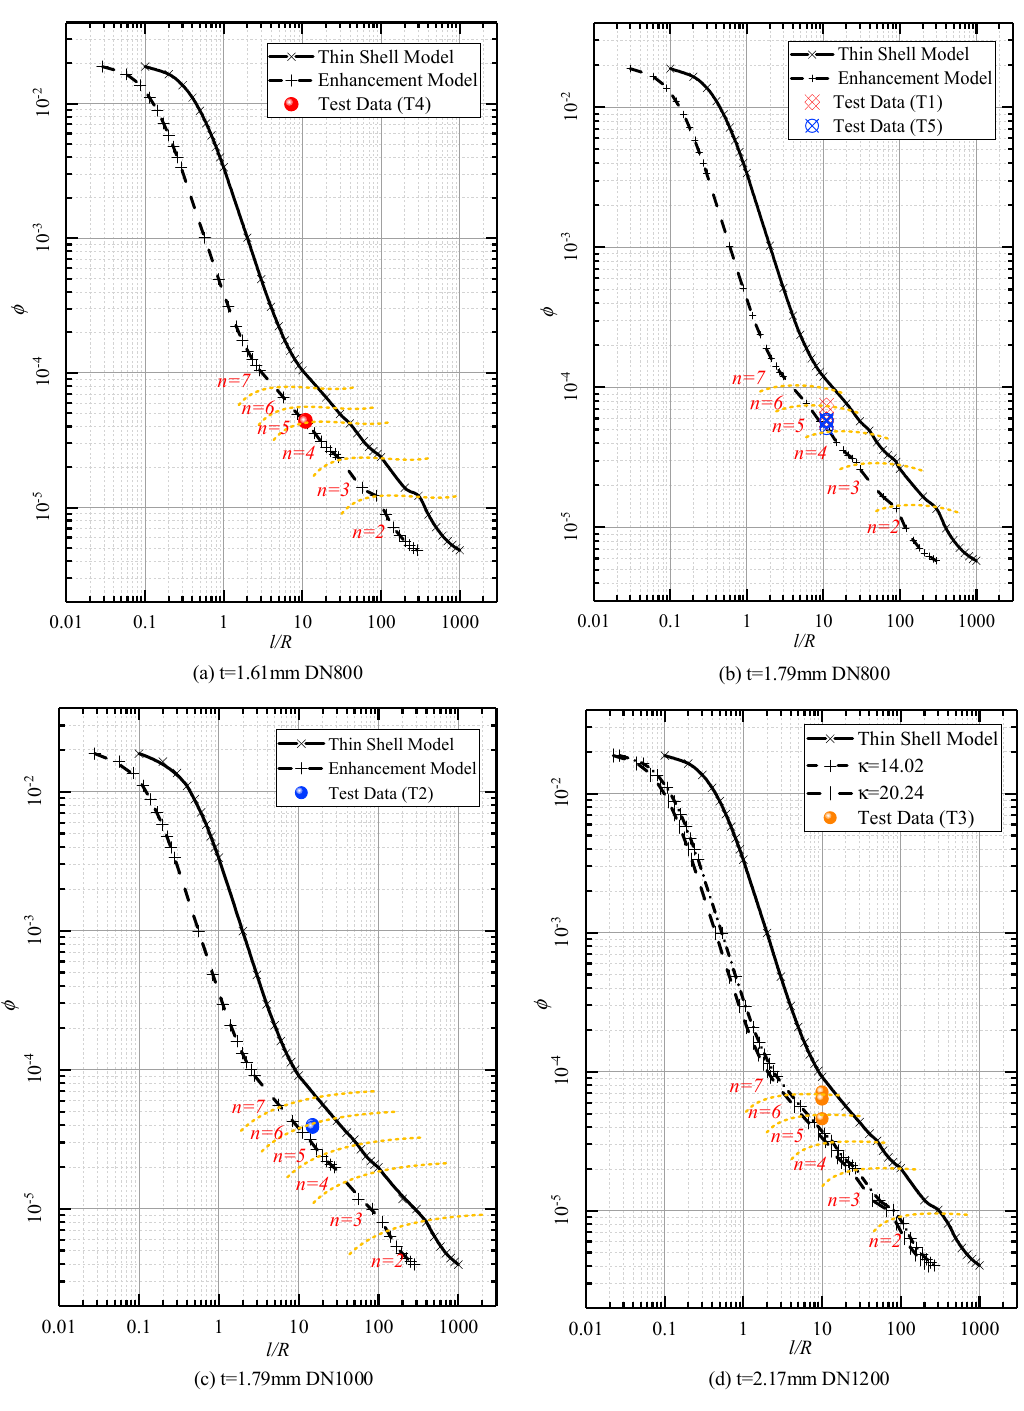
Figure 16. The φ - l/R principles for T1 to T5. Figure 16. The ϕ - l/R principles for T1 to